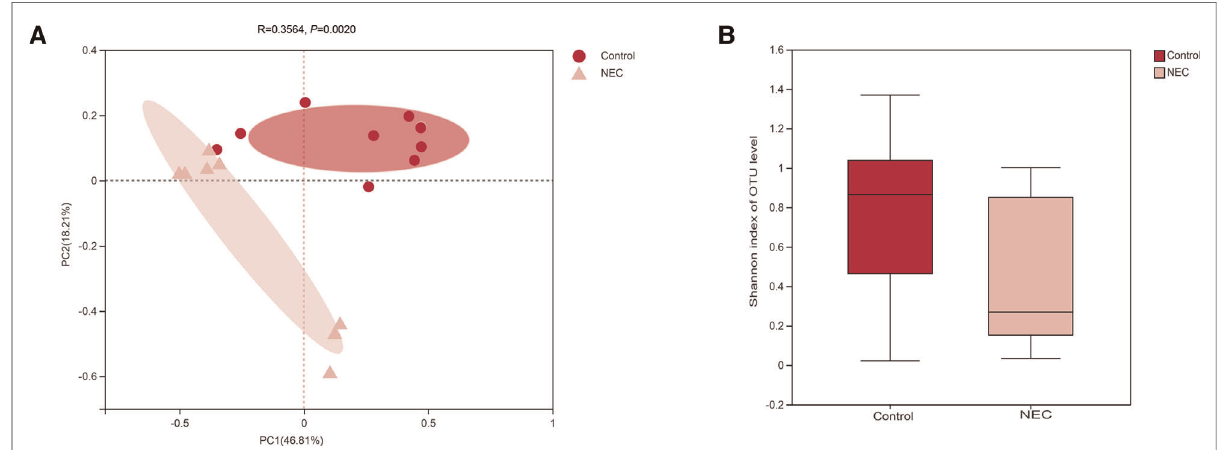
FIGURE 2 ( A ) principal component analysis (PCoA) of the gut microbiota; ( B ) shannon diversity index of the gut microbiota, Mann ⍰ Whitney U test